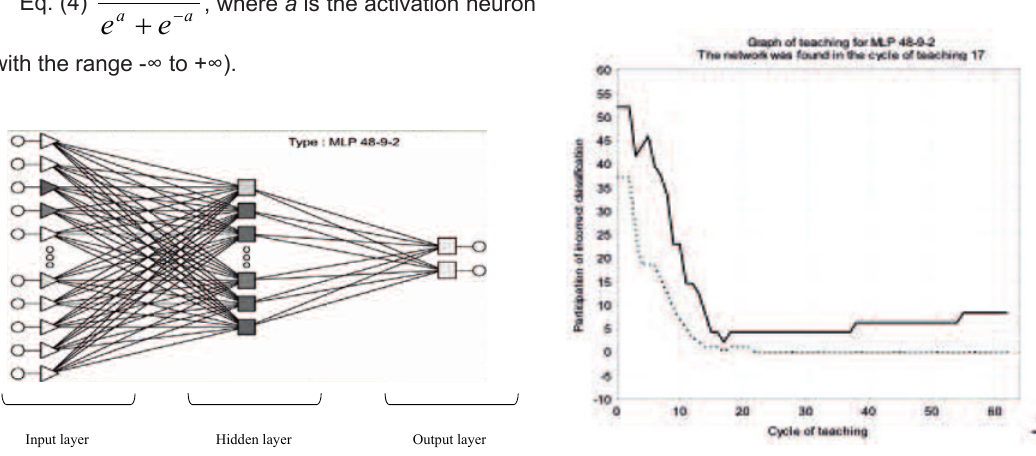
Figure 1. Architecture of the Artifi cial Neural Network applied. Figure 2. Graph of teaching for MLP 48-9-2